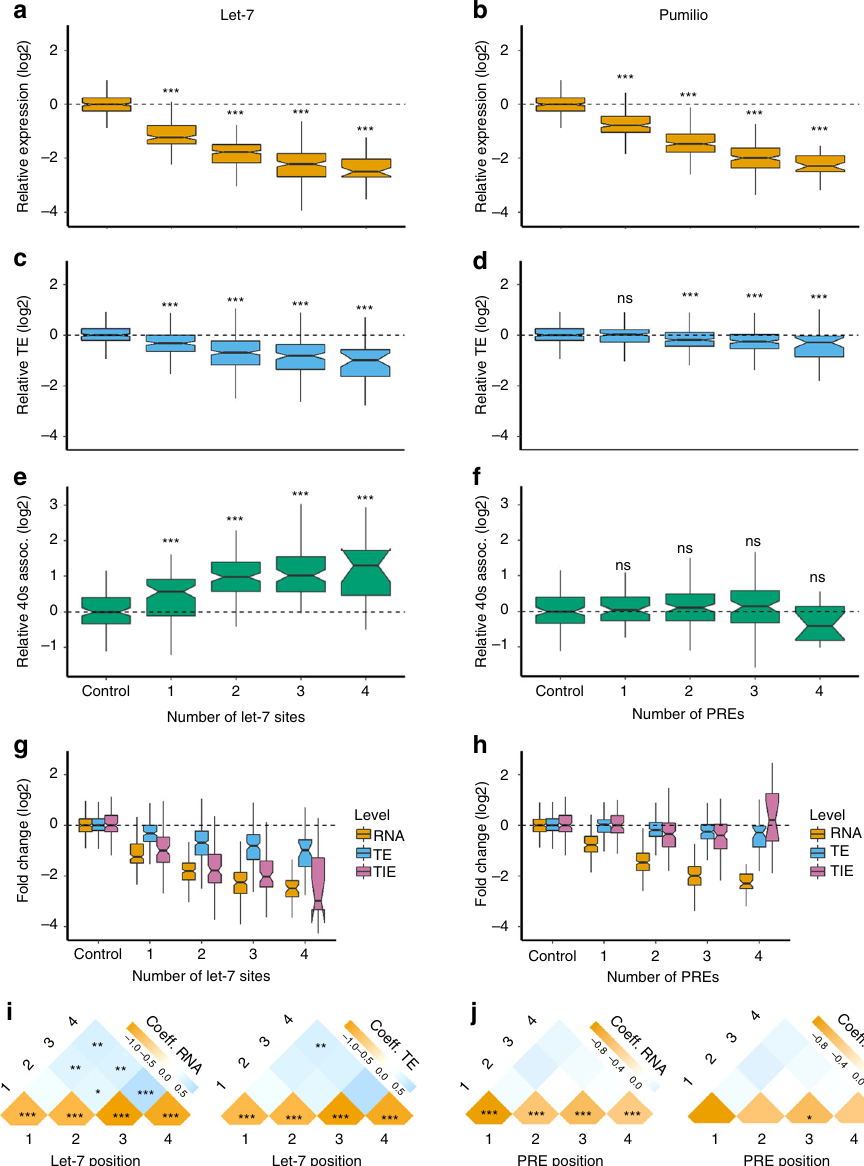
Fig. 2 PTRE-seq reveals differences in the mechanism of repression by miRNAs and Pumilio Fold change of RNA ( a ) TE ( c ), and 40S association ( e ) of let-7 binding site containing reporters within the PTRE-seq library. Fold change of RNA ( b ) TE ( d ), and 40S association ( f ), of PRE containing reporters within the PTRE-seq library. For a – d * P < 0.05, ** P < 0.01, *** P < 0.001, t -test with Bonferroni correction. For panels a – f the results for all constructs containing one, two, three, or four sites is shown. The data for each site in positions one-four are shown in Supplementary Fig. 9. Panels g and h show composite boxplots with fold change of RNA, TE, and translation initiation ef fi ciency (TIE) for let-7 and PRE respectively. TIE was calculated by normalizing polysome associated RNA/40S associated RNA. i The regression coef fi cients for linear models with parameters corresponding to let-7 alone or in combination with other let-7 sites at positions 1 – 4, or j , PREs alone or in combination with PREs at positions 1 – 4. In i and j , the left panels show the coef fi cients for RNA while the right panels show the coef fi cients for TE. * P < 0.05, ** P < 0.01, *** P < 0.001, t -test. Boxplot whiskers indicate the furthest datum that is 1.5*Q1 (upper) or 1.5*Q3 (lower). For clarity, outliers have been removed from boxplots but were used for statistical